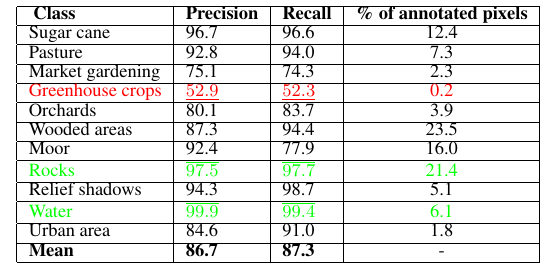
Table 3. Precision and recall by class for the DSLCC for all annotated pixels (880,828 pixels).